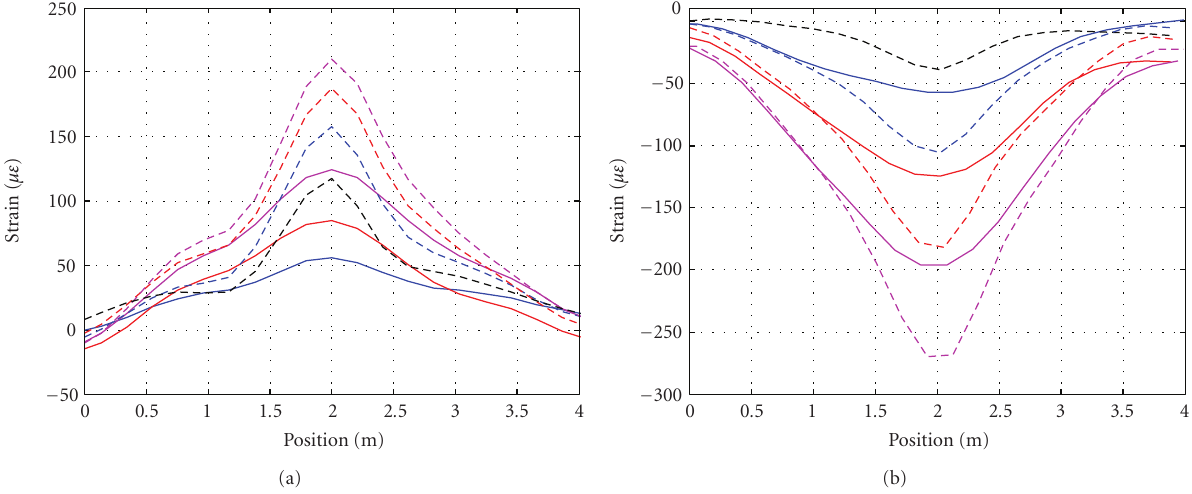
Figure 5: (a) Measured strain distribution along the length of the beam with fiber bonded with polyurethane (position D); (b) measured strain distribution along the length of the beam with fiber bonded with polyurethane (position C). Solid line = loading step. Dashed line = unloading step. Blue line = 50daN. Red line = 100daN. Magenta line = 150daN. Black line = 0 daN. sensors, using a height h of 10 cm for the dial gauge case, or h = 8.1 cm (i.e., the vertical distance between fibers A and B, or C and D) for the optical fiber